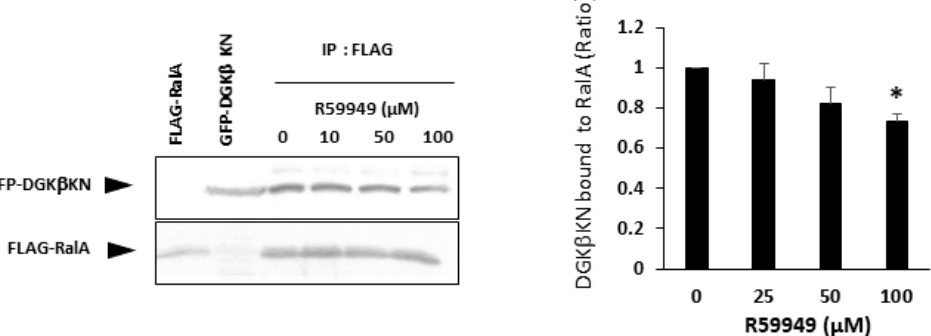
Figure 7. Effect of R59949 on the interaction between DGK β KN and RalA. Pull down assay was performed using COS-7 cells separately overexpressing FLAG-RalA mutants and GFP-DGK β KN in the presence of several concentrations of R59949. Three independent experiments were performed. The mean and SEM of density of bands are shown as the ratio to the WT DGK β . * p < 0.05 followed